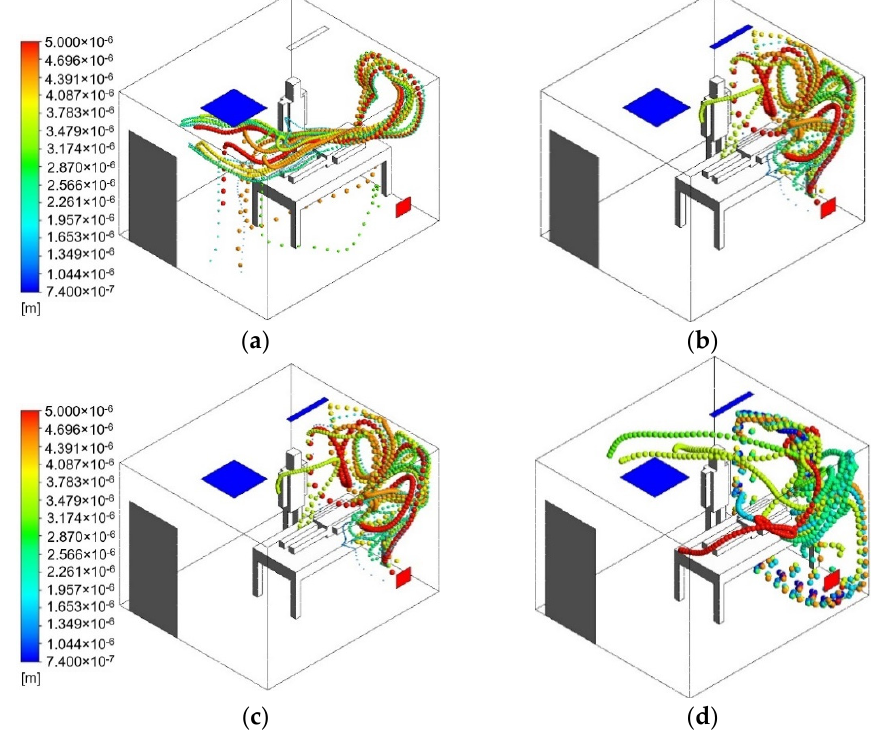
Figure 8. Particle trajectory pathway from the patient (0–120 s): ( a ) without air curtain ( b ) V = 0.5 m/s; ( c ) V = 0.75 m/s; ( d ) V = 1.0 m/s.